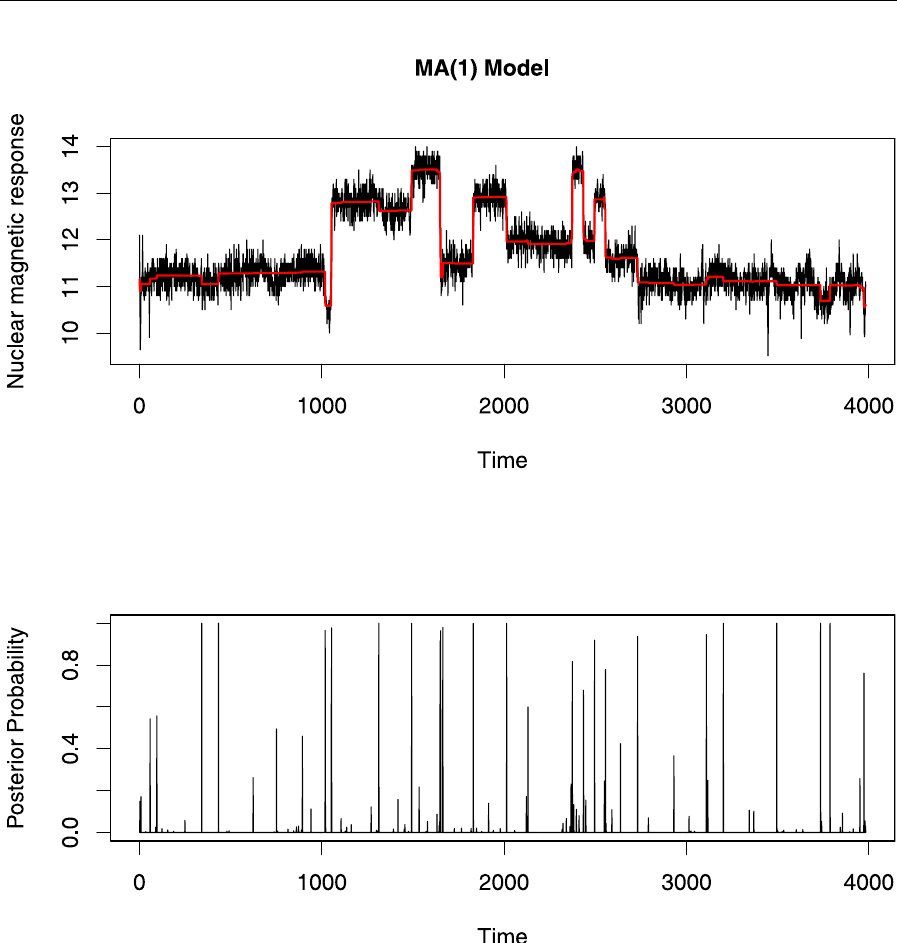
Fig 10. Top and bottom plot show the segment mean profiles and the change-point profiles for MA(1) model respectively. This model identifies more change-points than the AR(1)